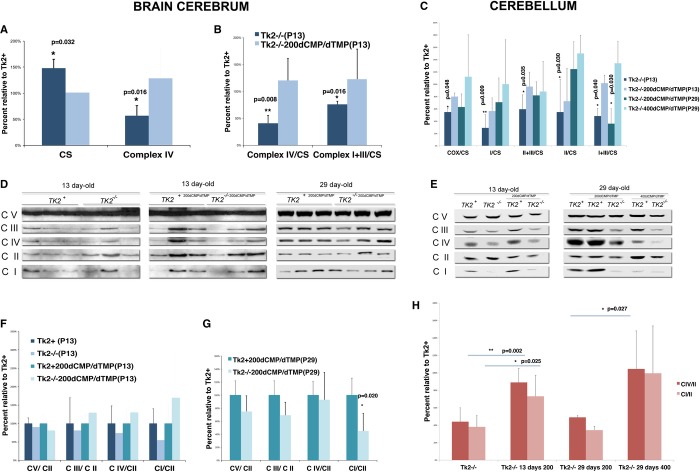
dCMP/dTMP efficacy on brain hemisphere and cerebellum biochemistryA, B   (A) Cerebral hemispheres of untreated Tk2−/− mice relative to untreated wild types showed significant increase in CS activity and deficiency of complex IV activity (micromole/min/mg tissue normalized to mg-protein; mean ± SD) as well as (B) defects of complexes IV and I+III activities when referred to CS (mean ± SD). In contrast, with 200 mg/kg/day dCMP/dTMP, activities of citrate synthase and complex IV were normal in cerebrum of 13-day-old Tk2−/−.C   In cerebellum of mutant mice at ages 13 and 29 days, activities of mitochondrial RC referred to CS (expressed as percent of Tk2+) showed treatment-dose-related increases.D–E   Western blot of OXPHOS protein (MitoProfile® Total OXPHOS Rodent WB Antibody Cocktail, MitoSciences®) in brain (D) and cerebellum (E) of 13-day-old untreated Tk2−/−, 13- and 29-day-old Tk2−/−200dCMP/dTMP mice, and cerebellum of Tk2−/−400dCMP/dTMP (expressed as percents relative to Tk2+).F–H   Quantitation of western blot bands demonstrated that treatment normalized levels of complexes I and IV protein in both brain cerebrum and cerebellum tissues at 13 days, but did not correct complexes I and III deficiencies in brain cerebrum and complexes I and IV in cerebellum at 29 days of age. Statistical analyses were performed using Tk2−/− versus Tk2−/−200dCMP/dTMP with P13 cerebral samples (F); Tk2−/−200dCMP/dTMP versus Tk2+200dCMP/dTMP with P29 cerebral samples (G); Tk2−/− versus Tk2−/−200dCMP/dTMP with P13 cerebellar samples (H); and Tk2−/−200dCMP/dTMP versus Tk2−/−400dCMP/dTMP with P29 cerebellar samples (H) *P < 0.05; **P < 0.005.Data information: Statistical analyses were performed with Mann–Whitney U-test and Unpaired t-test with Welch's correction. CS, citrate synthase; IV, cytochrome c oxidase (COX); I+III, NADH-cytochrome c reductase; I, NADH-dehydrogenase; II, succinate dehydrogenase; III, cytochrome c reductase; V, ATP synthase; P, postnatal day.